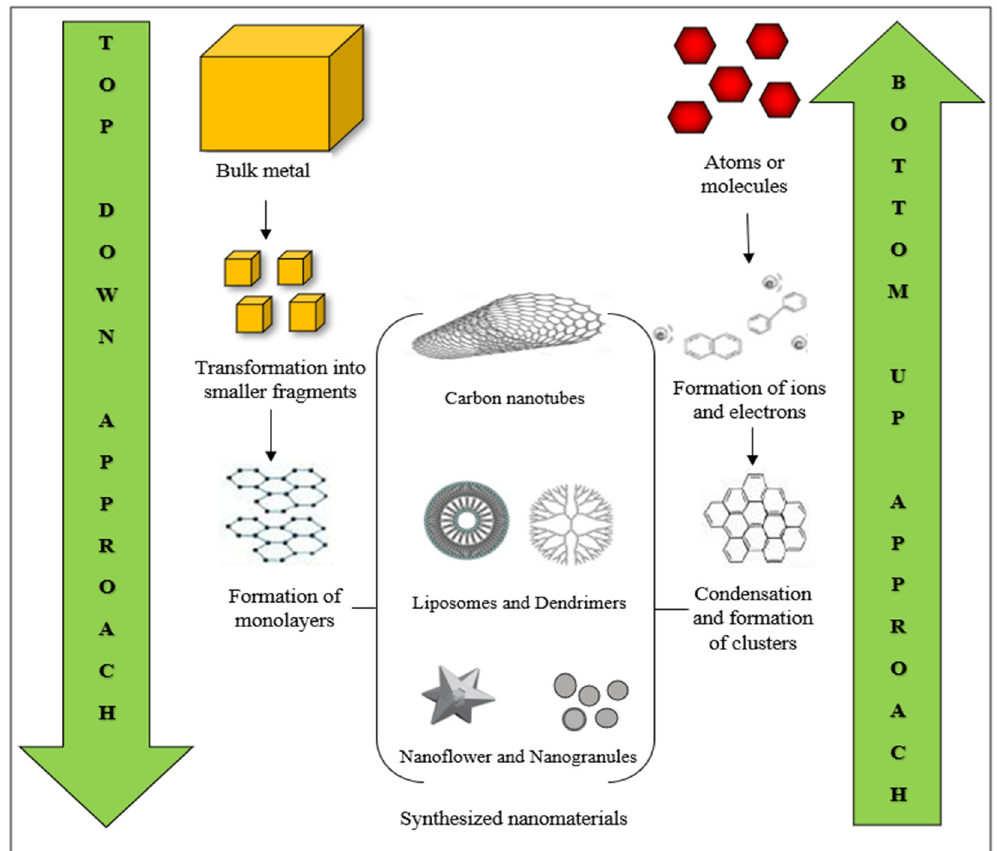
Fig. 1. Schematic representation of major approaches involved in the nanomaterial